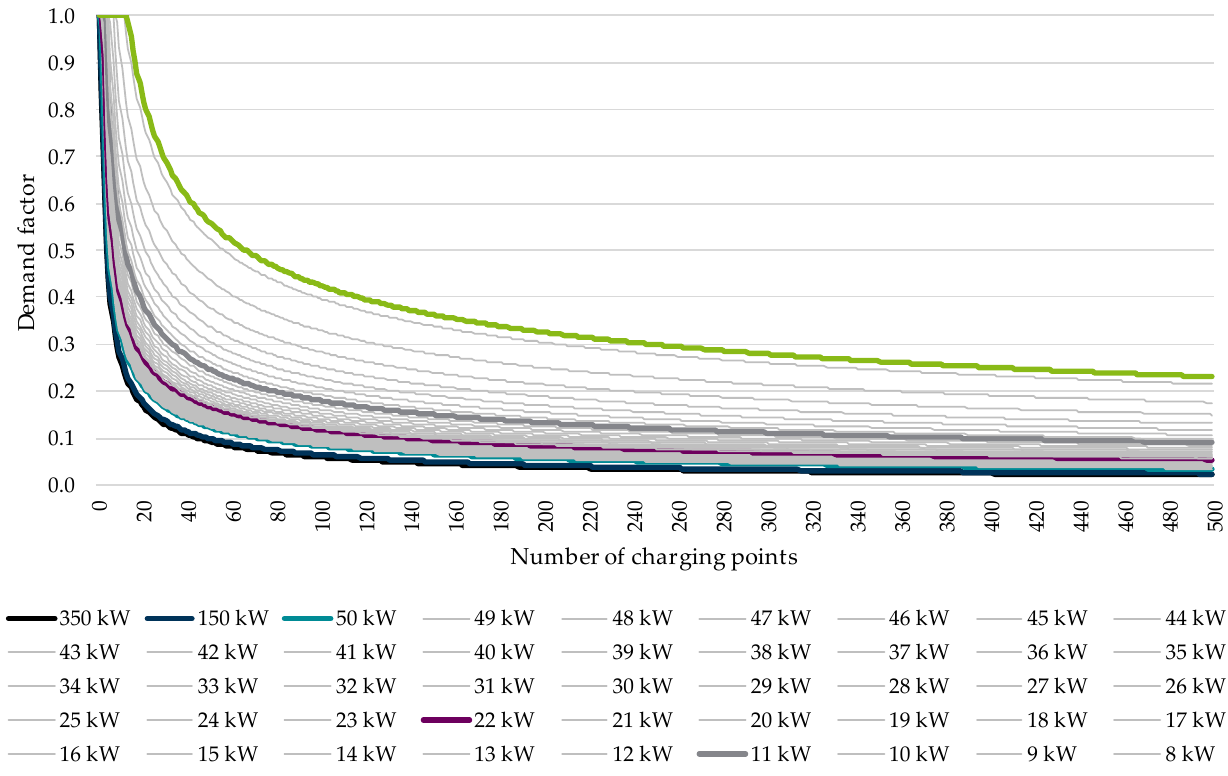
Figure 10. Example for the newly generated demand factors.